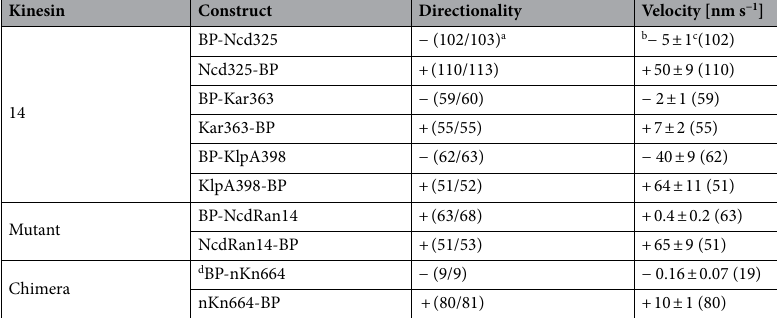
Table 1. Summary of direction and velocity of microtubule gliding driven by monomeric kinesins. The minus (−) and plus (+) sign refer to the minus-end and plus-end polarity, respectively. a Values of denominator in parentheses are the number of microtubules analyzed and values of the numerator are the number of polarity- marked microtubules which moved as indicated (+ or −). b Velocity data is given as mean ± SD. c In assays using either BP-Ncd325, Ncd325-BP, BP-Kar363, Kar363-BP, BP-KlpA398, KlpA398-BP, BP-NcdRan14, NcdRan14-BP or nKn664-BP, of 109, 144, 67, 60, 65, 55, 91, 53 and 84 polarity-marked microtubules in the observation field, 109, 116, 63, 55, 63, 52, 74, 53 and 83 glided. The other 0, 28, 4, 5, 2, 3, 17, 0 and 1 did not glide. Only gliding microtubules that were > 1 µm in length and did not cross each other were analyzed. Values in parentheses are the number of microtubules analyzed. d Results are from Yamagishi et al. 38 .